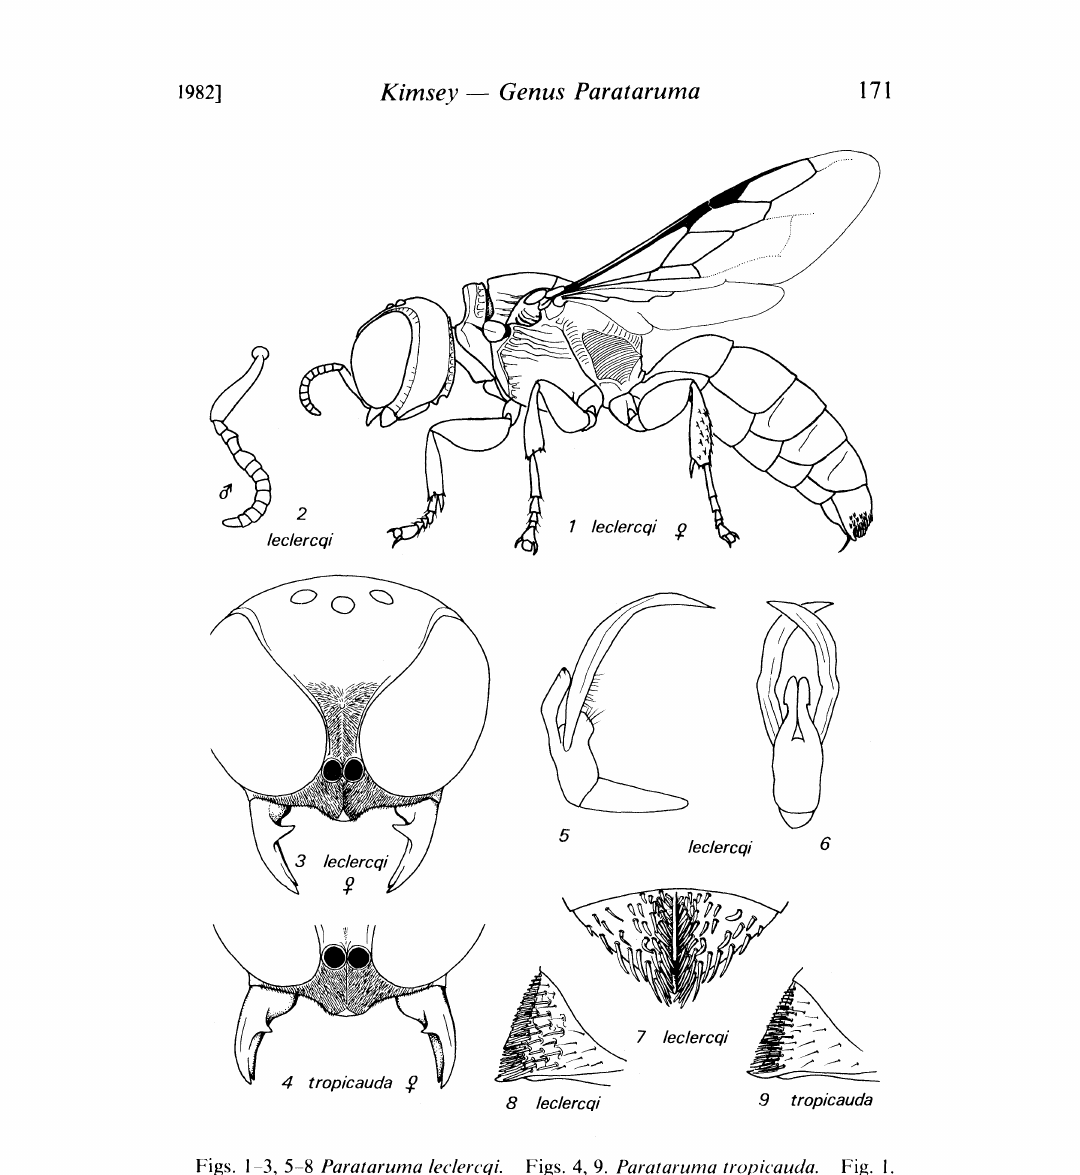
Figs. 1-3, 5-8 Parataruma leclercqi. Figs. 4, 9. Parataruma tropicauda. Fig. 1. Lateral view of female. Fig. 2. Male antenna. Figs. 3 4. Complete and partial front view of female face. Figs. 5-6. Lateral and dorsal views of male genital capsule. Figs. 7 9. Female pygidium, dorsal (7) and lateral (8, 9)